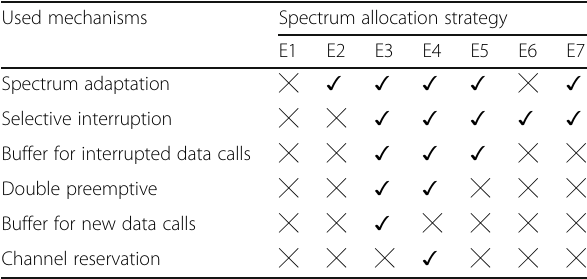
Table 2 Characteristics of the analyzed strategies Used